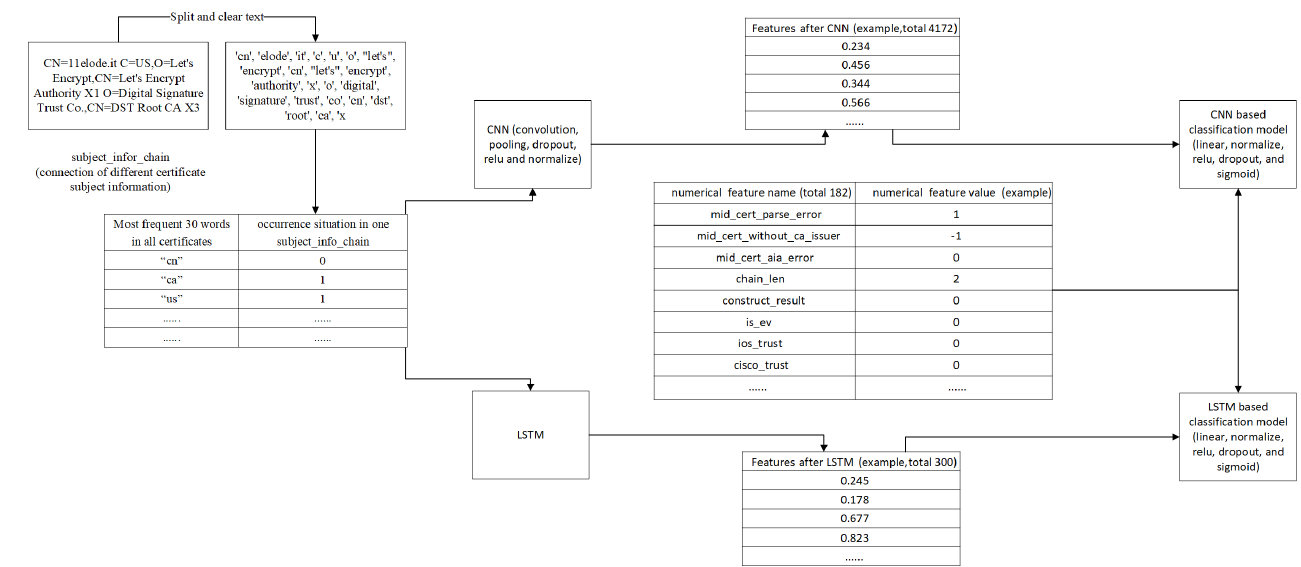
Figure 3. The architecture of networks with convolutional neural network (CNN) and long short-term memory